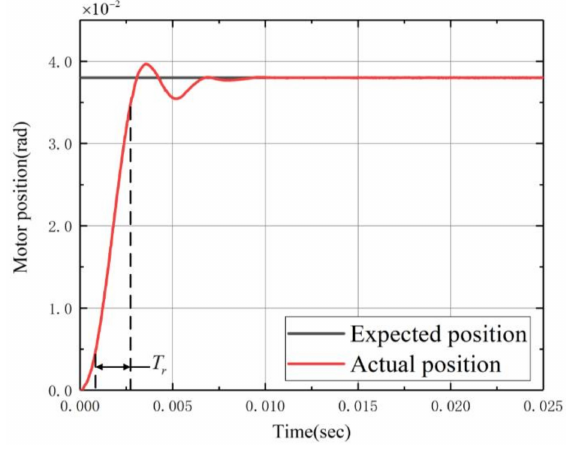
Figure 5. Step-responses in 10% of the whole stroke (0.038 rad).